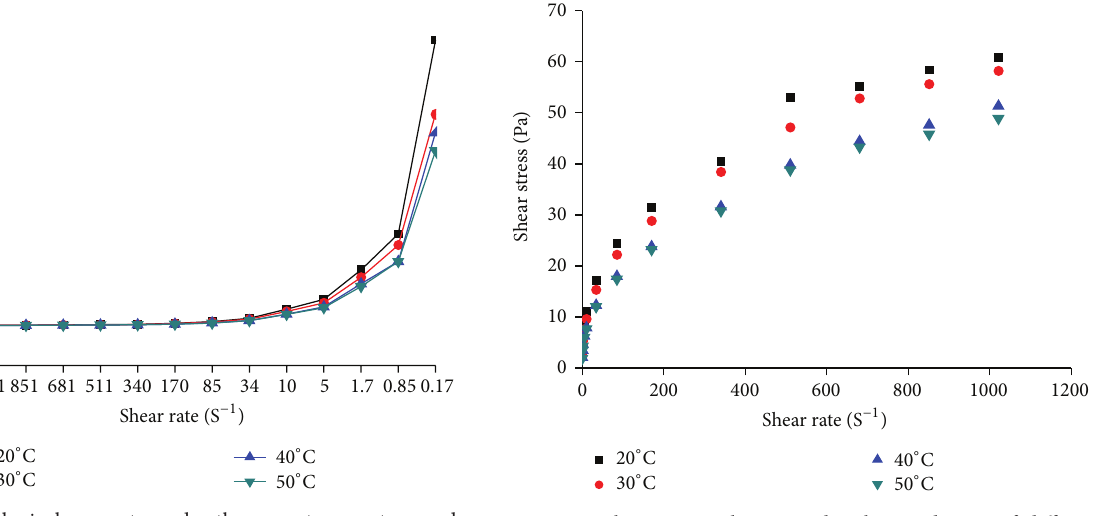
Figure 6: Shear stress change under the conditions of different temperatures and different shear